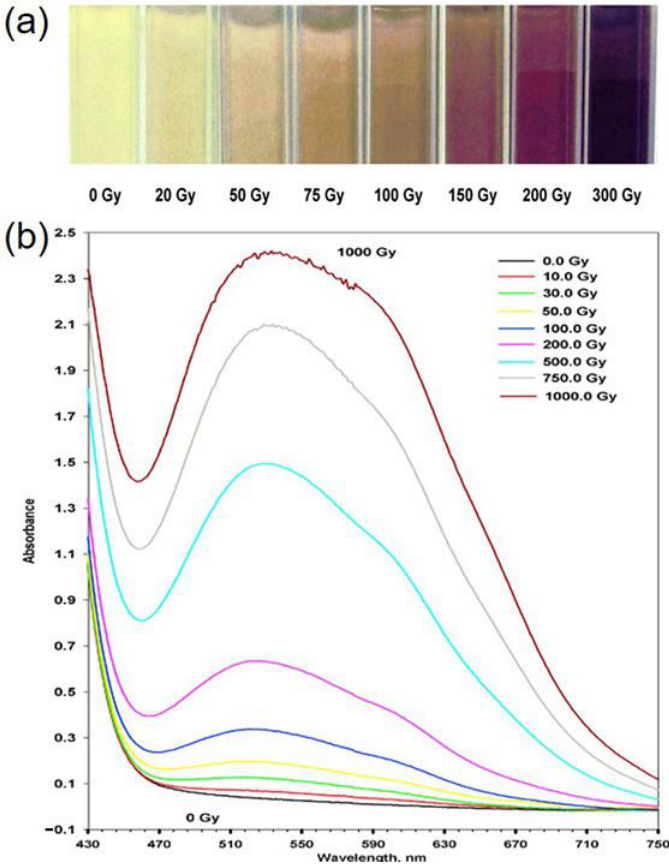
Figure 5. ( a ) Digital images and ( b ) UV-Vis spectra of NBT gel dosimeters, adapted from ref. [64] with permission from Elsevier.